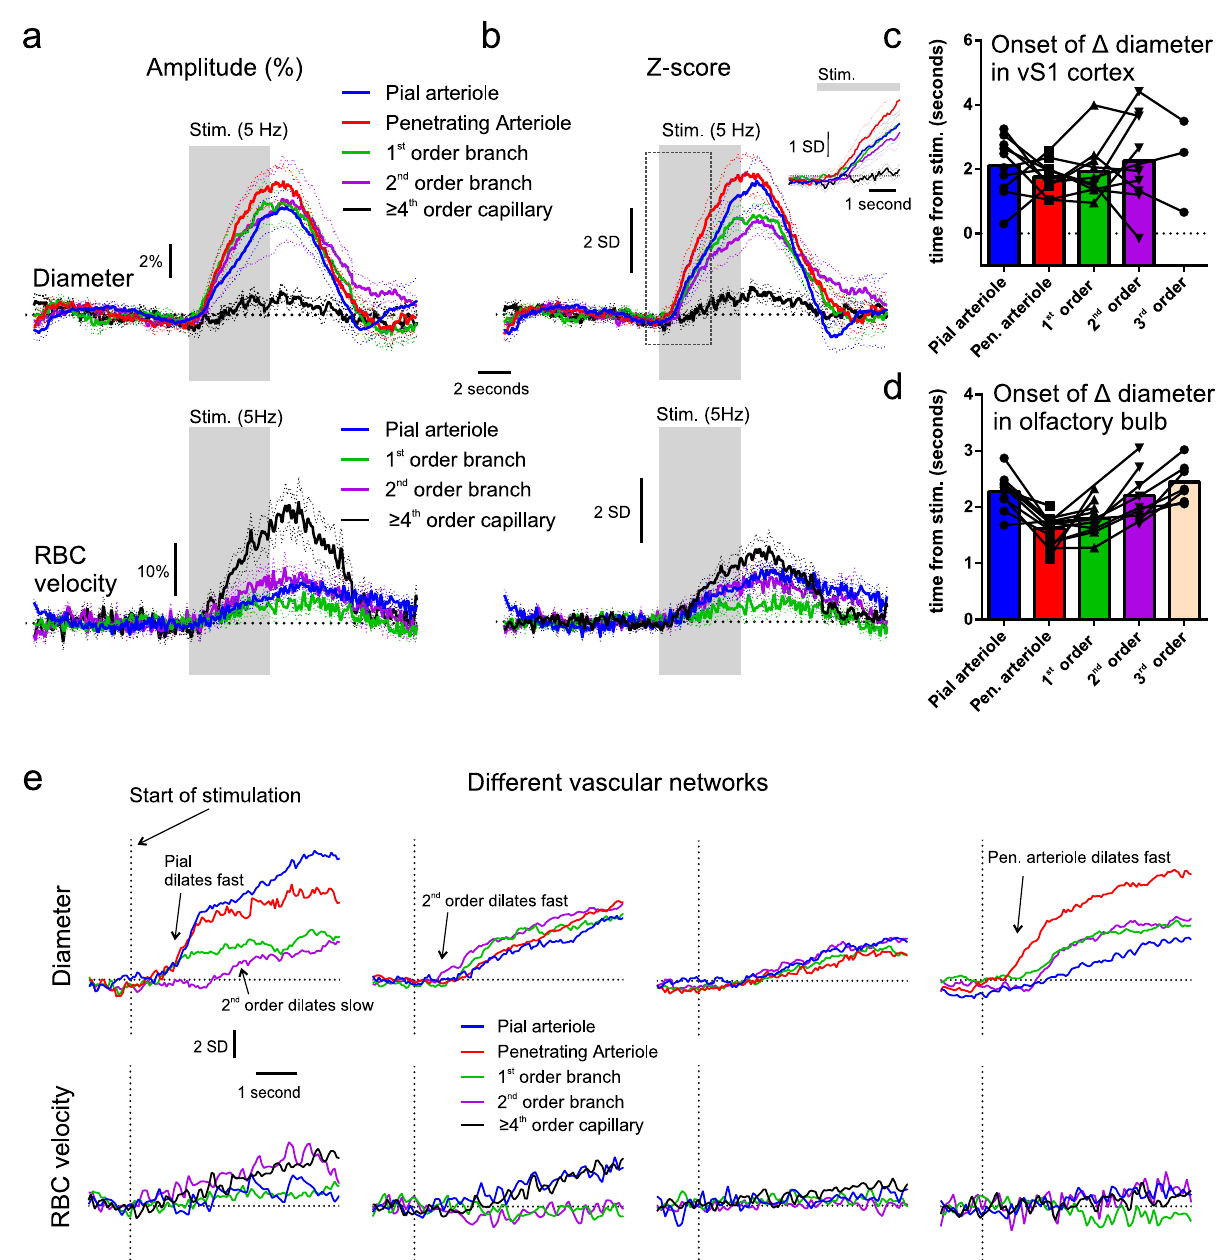
Fig. 2 Diversity of functional hyperemia onset times across the vascular arbor of vS1. a Average changes in diameter (top) and RBC velocity (bottom) of different vascular compartments in percent increase from baseline. b Average z -score changes in diameter (top) and RBC velocity (bottom) of different vascular compartments. Dotted lines in a and b represent SEM. Dotted line box outlines zoomed-in inset in the top right corner. c Histogram of onset times (25% of fi t peak) across different compartments in vS1 cortex. Data in a – c represent 10 vascular networks from 6 mice. d Histogram of onset times (25% of fi t peak) across different compartments in OB, made on a data set primarily formed from previously published experiments 1 . Symbols in c and d represent data points from individual experiments. e Examples of the timing of diameter and velocity increases ( z -score), from 4 different vascular